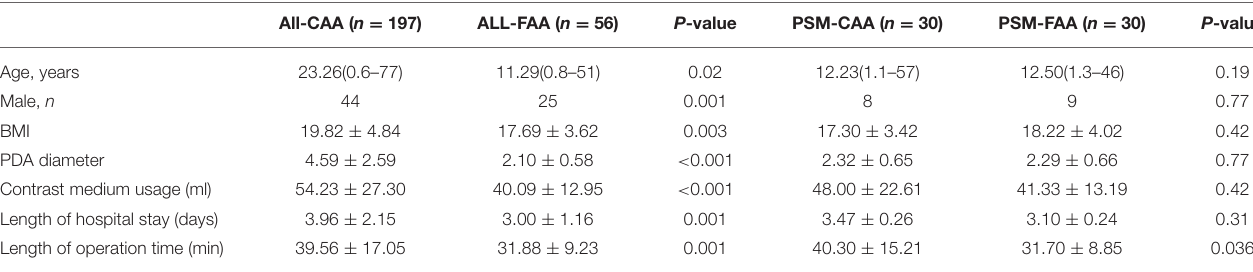
TABLE 2 | Summary of baseline of CAA and FAA groups.